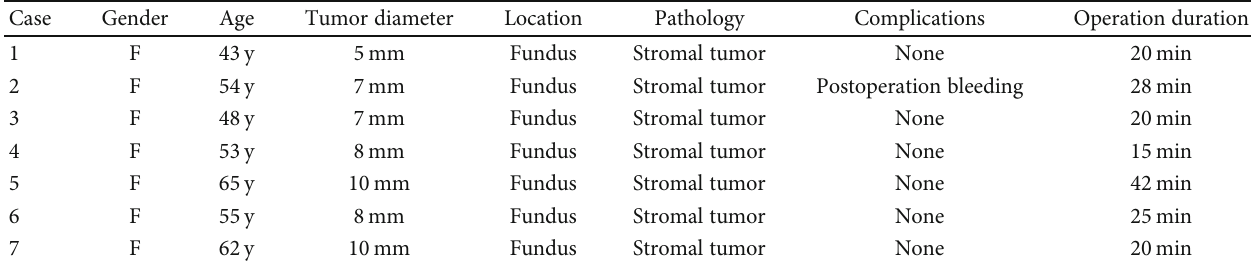
Table 1: Patient demographics and clinical